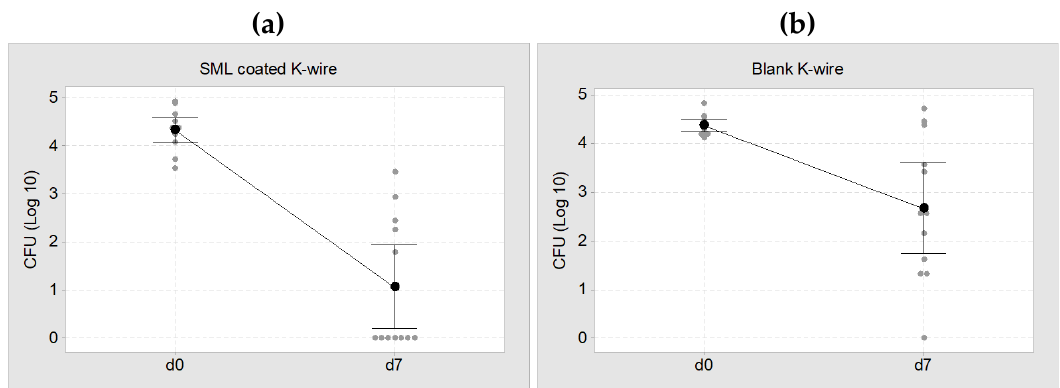
Figure 6. Individual value plot of CFU at d0 (implantation, ~ 2 × 10 4 CFU) and d7 (explantation). ( a ) SML coated K-wires, mean CFU = 353 ± 529 CFU. This equals a cure rate of 58% ( b ) Blank K-wires, mean CFU = 9.282 ± 10.585 CFU. This equals a cure rate of 8%. The black dots represent the mean value of each group with a 95% confidence interval.